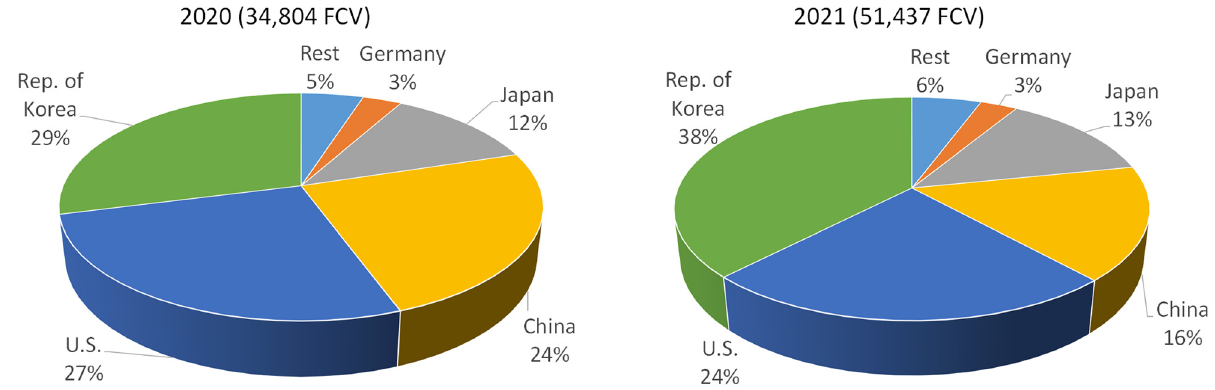
Figure 11. FCVs in the top five countries with more than 1000 fuel cell vehicles on the road as of the end of 2021: change of shares 2020–2021.